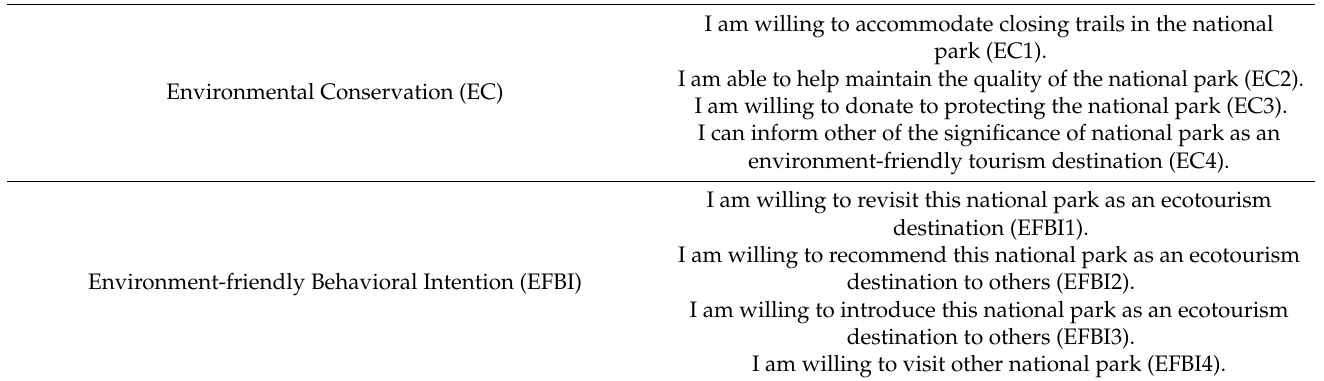
Reality to limits of growth